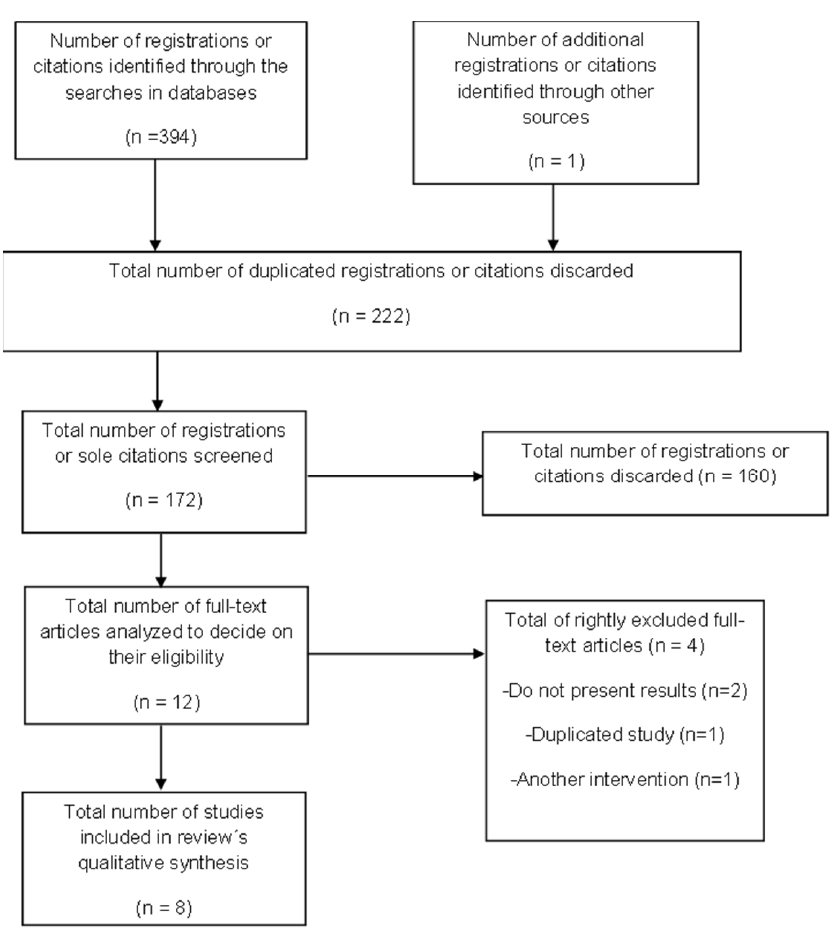
Figure 1. Distinct phases of the selection procedure of the studies involved in the review. The design of the PICO question was based on the study selection criteria [13,16,17] (Table 1). Table 1. Elements of the PICO question.